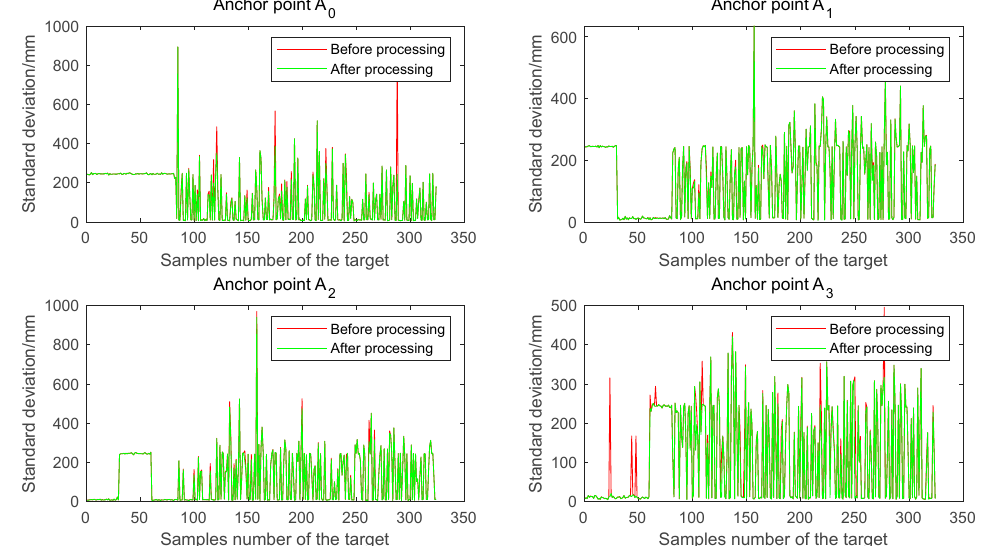
Figure 6. The standard deviation comparison of the samples before and after processing with signal interference.